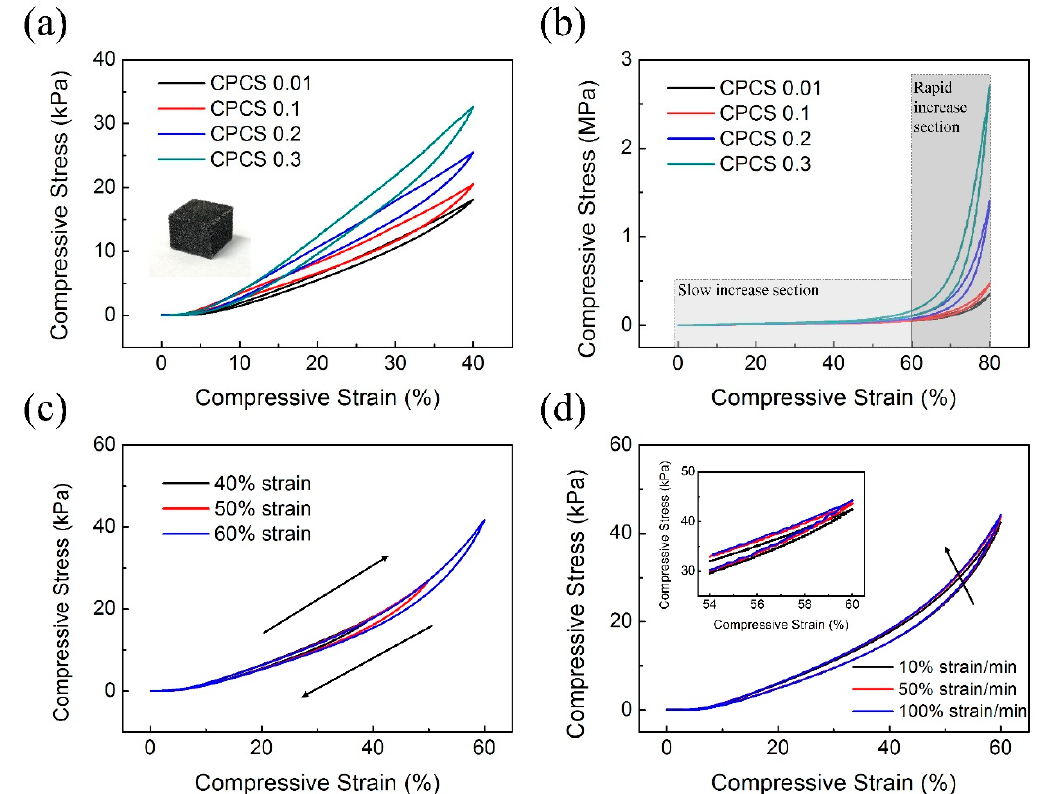
Figure 5. Mechanical characterization of the CPCS. Compressive stress–strain curves of CPCS with different concentrations of CNTs at (a) 40% ( b ) and 80% strain. After the pores of the CPCS were closed, the compressive stress rapidly increased. ( c ) Compressive stress–strain curves of CPCS 0.01 at different maximum strains of 40%, 50%, and 60%. ( d ) Curves tested under different strain rates Inset: enlarged graph from the 54% to 60% strain range.